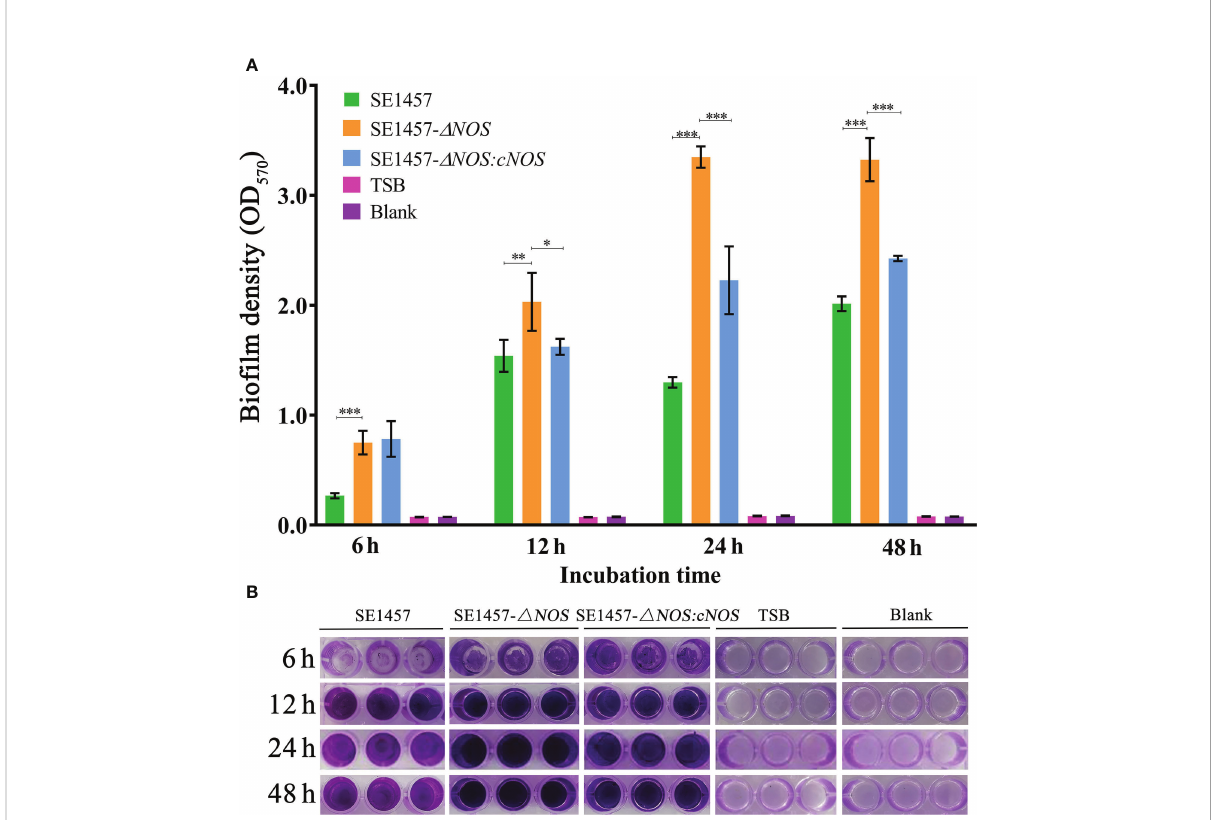
FIGURE 4 Determination of bacterial bio fi lm formation. Experimental data are presented as the mean ± SD obtained from three independent experiments. SE1457 , SE1457- D NOS and SE1457- D NOS:cNOS are the wild strain, deletion strain and complement strain, respectively. * p < 0.05, ** p < 0.01, *** p < 0.001. (A) Semi-quantitative determination of the bio fi lm formation of S. epidermidis at different culture time points. (B) Qualitative determination of the bio fi lm formation of S. epidermidis by crystal violet